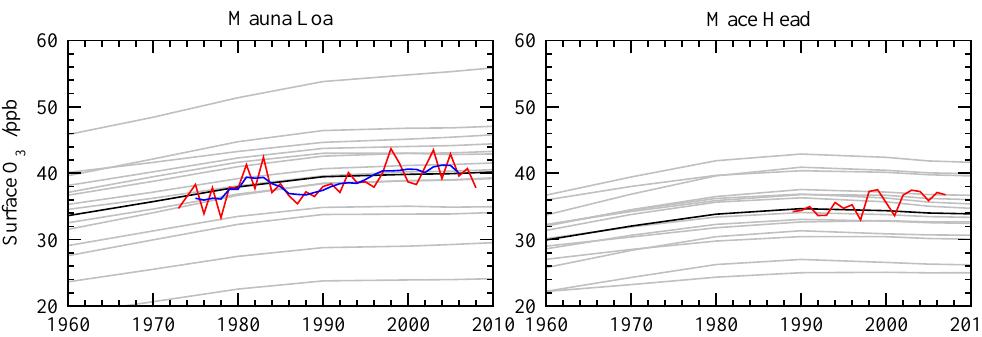
Fig. 7. Annual mean surface O 3 trends at Mauna Loa and Mace Head between 1960 and 2010 for individual models (grey) and ensemble mean (black) against annual mean observed surface O 3 (red). The 5-year running mean of the observations at Mauna Loa is shown in blue.